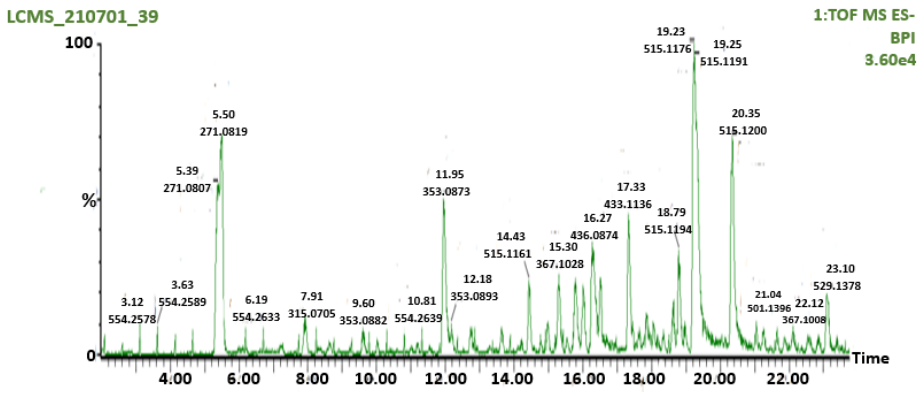
Figure 2. LC-MS chromatogram screening of AAHPE.